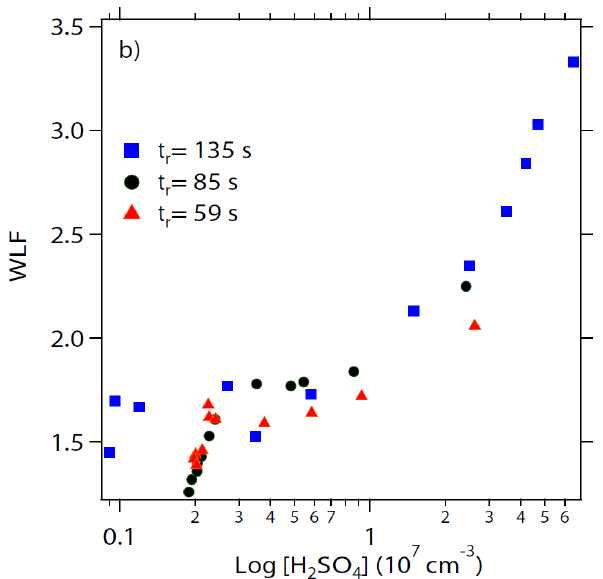
Fig. 2b. The measured WLF with two CIMSs located at the begin- ning (initial [H 2 SO 4 ]) and end of the nucleation reactor (residual Figure 2b. The measured WLF with two CIMSs located at the beginning (initial [H 2 SO 4 ]) and 626 [H 2 SO 4 ]) as a function of initial [H 2 SO 4 ]. WLF is the ratio of ini- tial to residual [H 2 SO 4 ]. RH=20%. end of the nucleation reactor (residual [H 2 SO 4 ]) as a function of initial [H 2 SO 4 ]. WLF is the ratio 627 of initial to residual [H 2 SO 4 ]. RH = 20%. 628